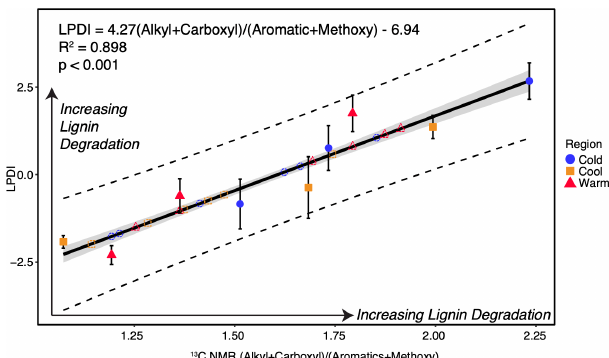
Figure 2. Lignin phenol diagenesis index (LPDI) vs. the CP-MAS 13 C NMR alkyl + carboxyl / aromatics + methoxy ratio for all re- gions and all organic layers (including predicted values of LPDI from the 13 C NMR ratio, which are given in open symbols and dashed lines and fall along the prediction line), including confidence of fit (grey shading) and confidence of prediction (dotted lines) at 95%. Standard error of predicted values falls within the confidence of fit (grey shading), while standard deviation of measured values are calculated from observed plot-level variation within each site and are depicted with error bars.